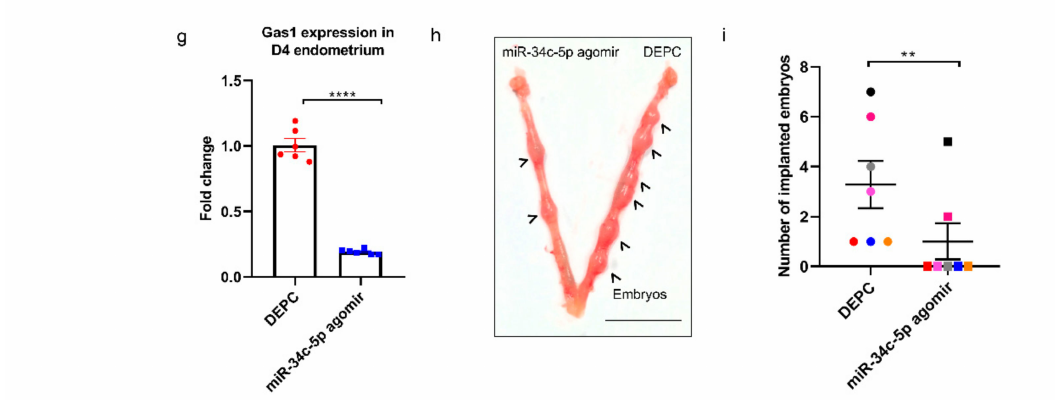
Figure 6. miR-34c-5p regulated embryo implantation by targeting GAS1 in endometrium during early pregnancy. ( a ) The regulating relationship between GAS1 and miR-34c-5p, the mature sequence of miR-34c-5p in mouse and human, was predicted by Targetscan. ( b , c ) The relative expression of GAS1 and miR-34c-5p in mouse endometrium was detected by qRT-PCR during early pregnancy. ( d ) The protein expression level of GAS1 in mouse endometrium. ( e ) miR-34c-5p regulated the expression of GAS1 in endometrium. ( f ) miR-34c-5p regulated successful embryo implantation. ( g ) The expression of GAS1 in D4 mouse endometrium after injecting miR-34c-5p agomir in D2. ( h , i ) The e ff ect of miR-34c-5p agomir injected in vivo on the number of embryos. Bar = 1 cm. ** P < 0.01, *** P <